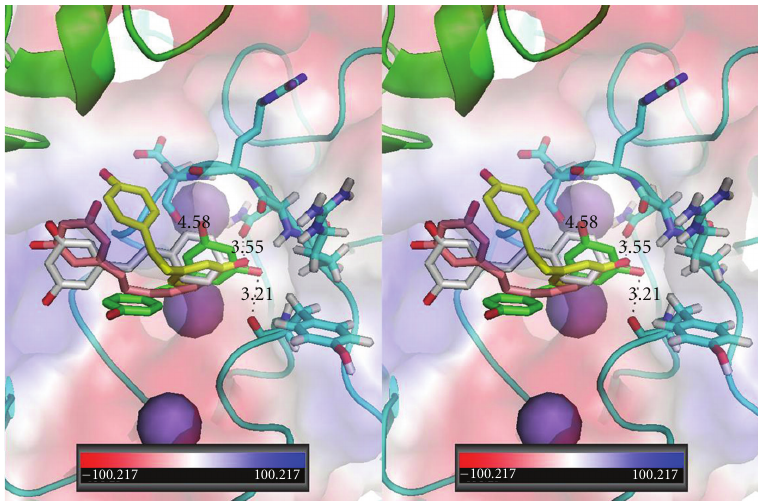
Figure 10: Stereoview of α v β 3 integrin RGD showing cis -resveratrol (green, Ca1), cis -resveratrol (yellow, Ca2), trans -resveratrol (beige, Ca1), and trans -resveratrol (grey, Ca2) and the residues that make contact with the RGD site. The purple spheres are Mg 2+ ions.